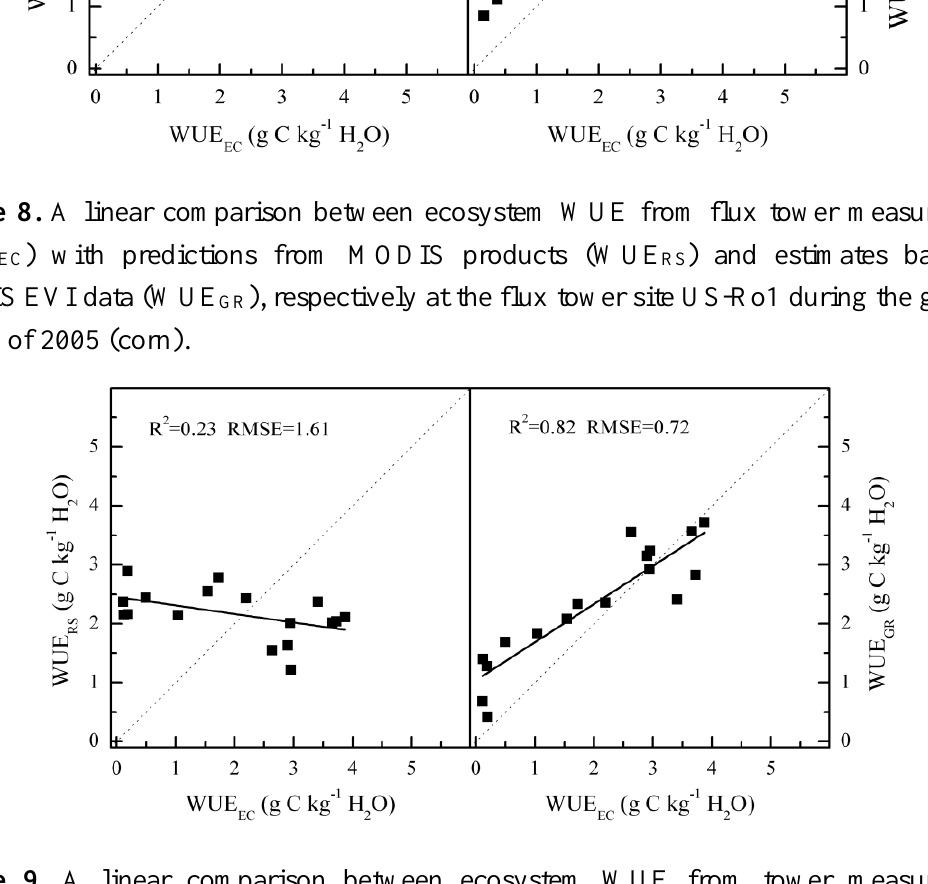
Figure 9. A linear comparison between ecosystem WUE from tower measurements (WUE EC ) with predictions from MODIS products (WUE RS ) and estimates based on MODIS EVI data (WUE GR ), respectively at the flux tower site US-Ro1 during the growing season of 2006